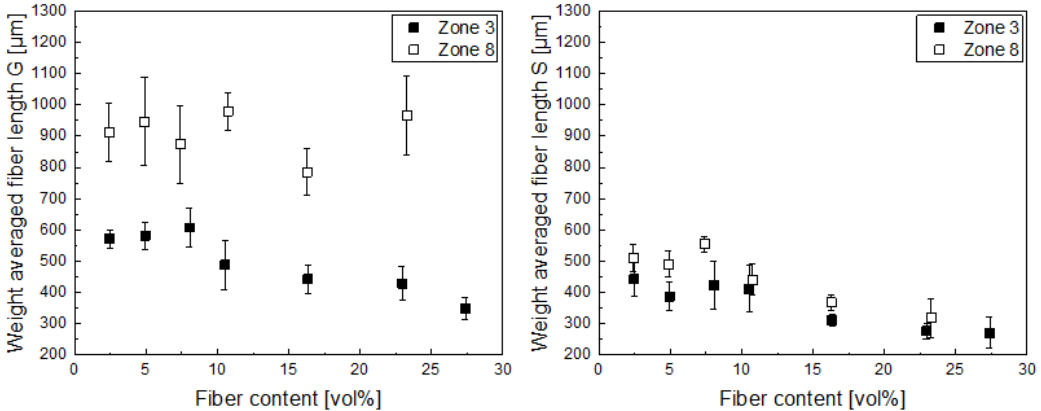
Figure 3. The weight average fiber length over the fiber volume content of the granules (G, ( left )) and the universal test specimen (S, ( right )) for carbon-fiber polypropylene composites produced with two different dosing positions in compounding (zone 3 and 8).